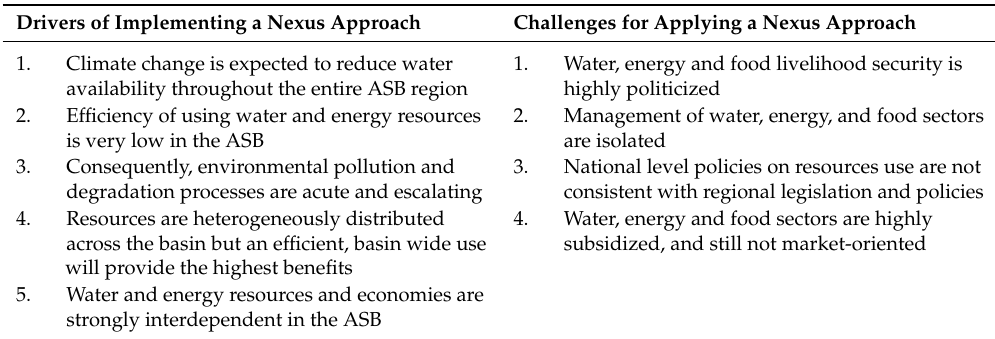
Table 5. Drivers and challenges of implementing a transboundary, nexus-based, resource